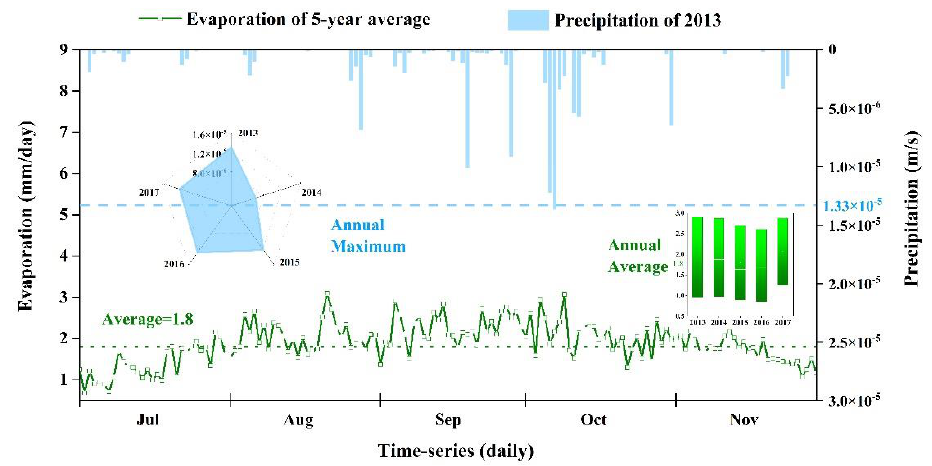
Figure 9. Averaged precipitation and evaporation during the period of vegetation growth season over the DYK case domain.